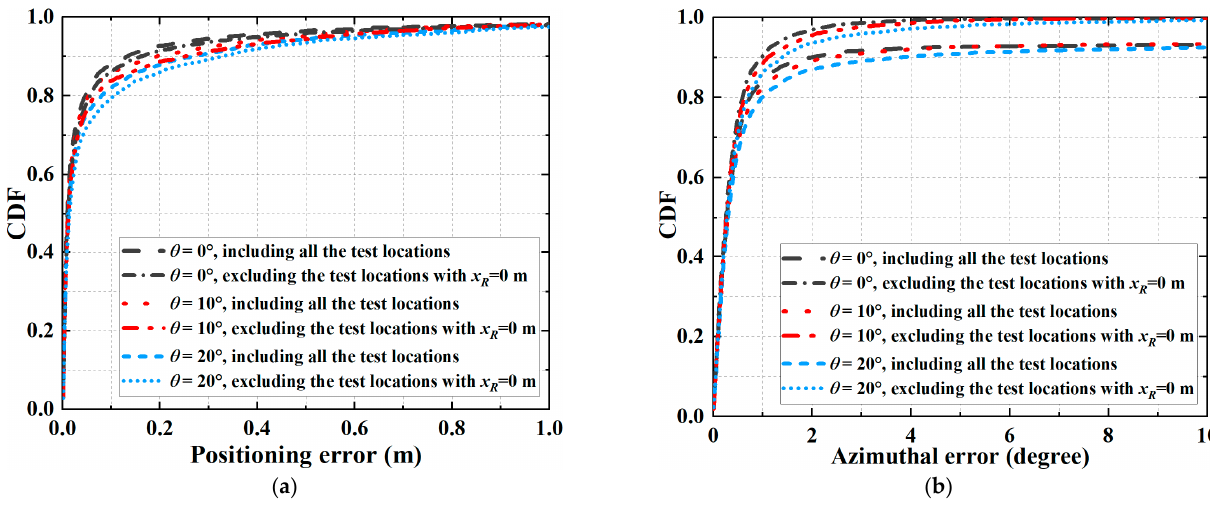
Figure 10. CDFs at the height of 1 m for: ( a ) 3D positioning errors; and ( b ) azimuthal errors. ( θ = 0°, 10°, and 20°).